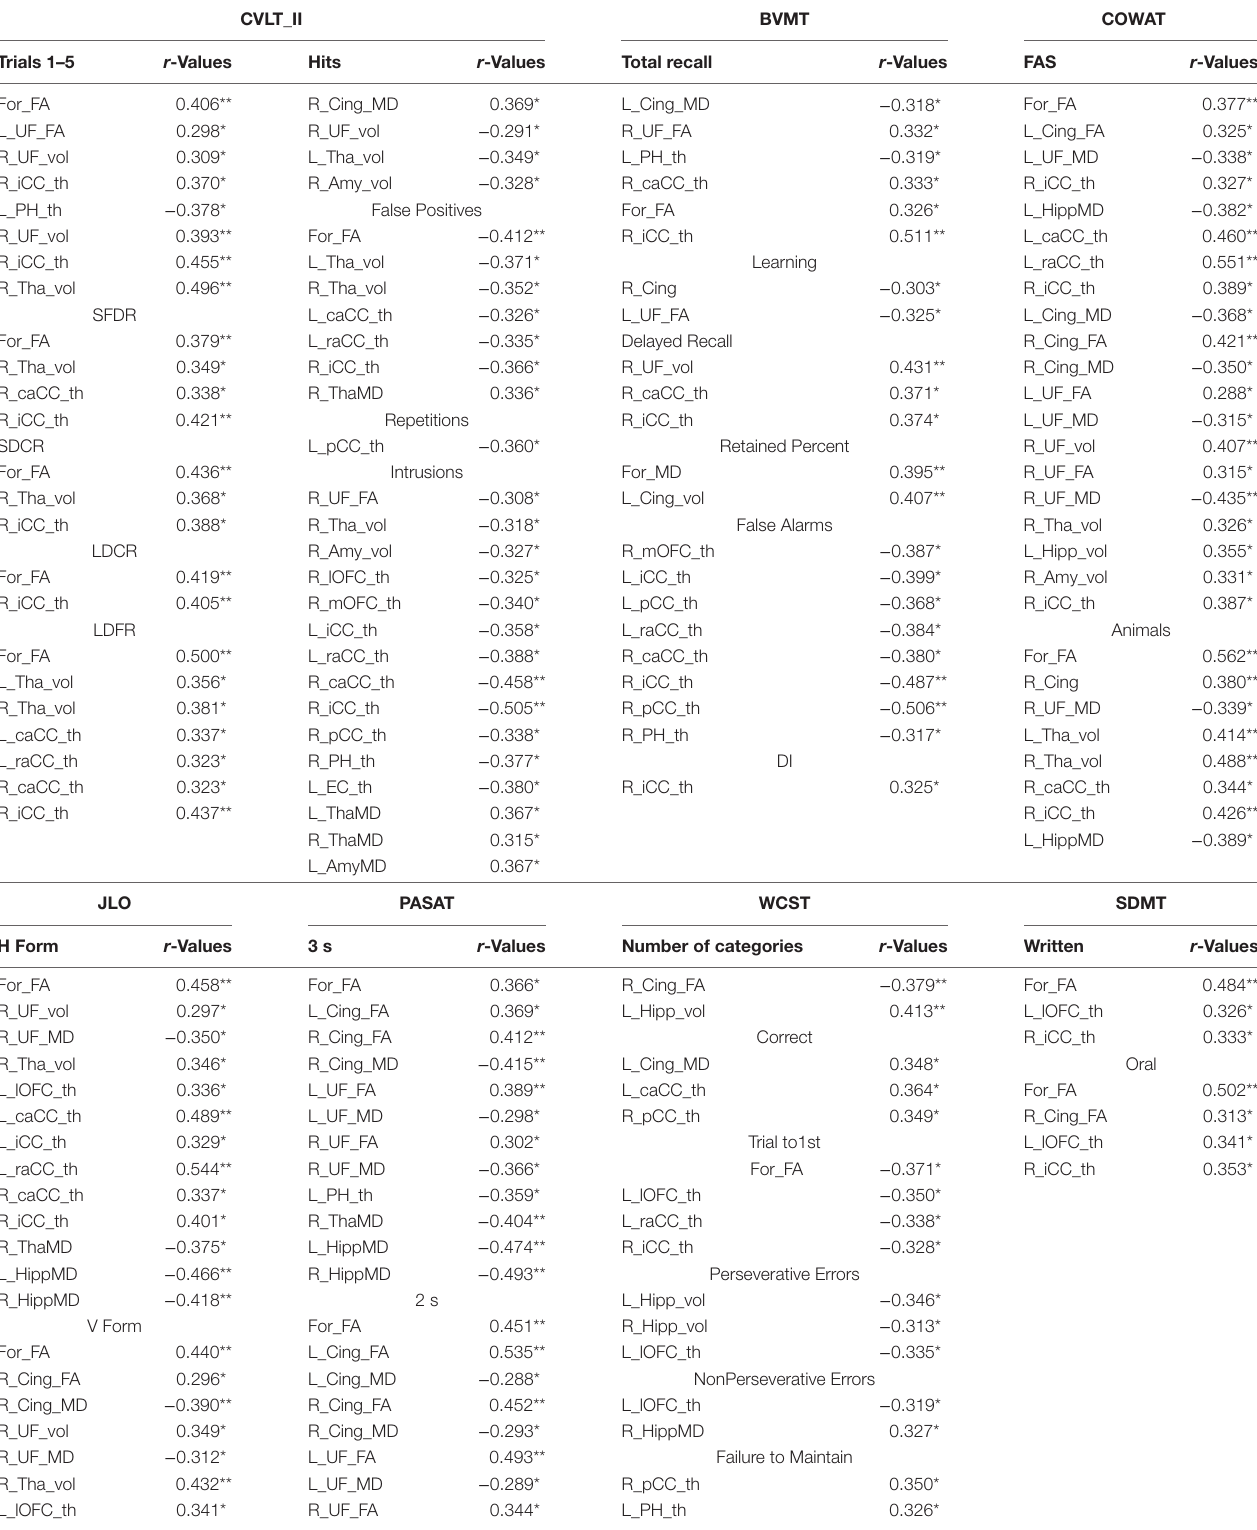
TaBle 3 | Significant correlations are shown for California Verbal Learning Test 2nd version (CVLT_II), Brief Visuospatial Memory Tests (BVMT), symbol digit modality test (SDMT) and Paced Auditory Serial Addition Test (PASAT) 3 seconds (3 s) and 2 second (2 s) tests, Controlled Oral Word Association Test (COWAT), Benton Judgment Line of Orientation (JLO), Wisconsin Card Sorting Test